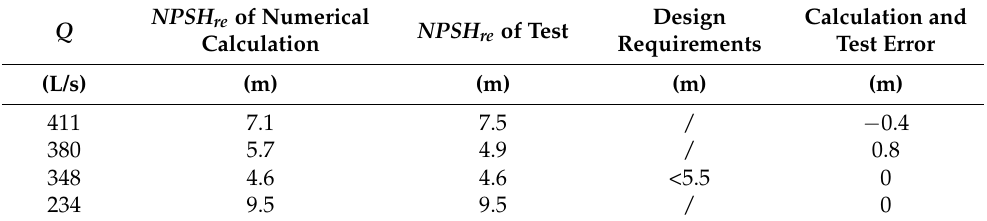
Table 4. The numerical calculation and test critical cavitation error analysis table.